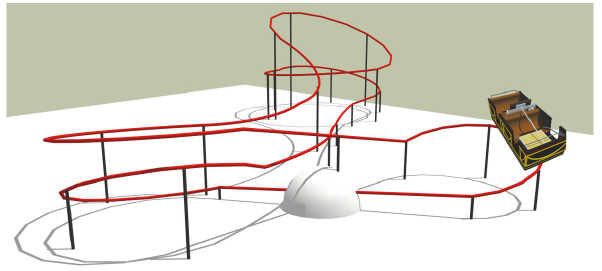
Figure 2: An outline of the rollercoaster “Odinexpressen” in Tivoli Gardens, Denmark (not to